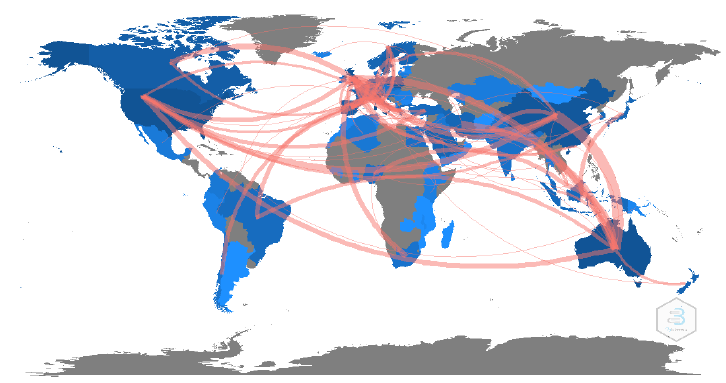
Figure 12. An overview of cooperation between countries/regions.